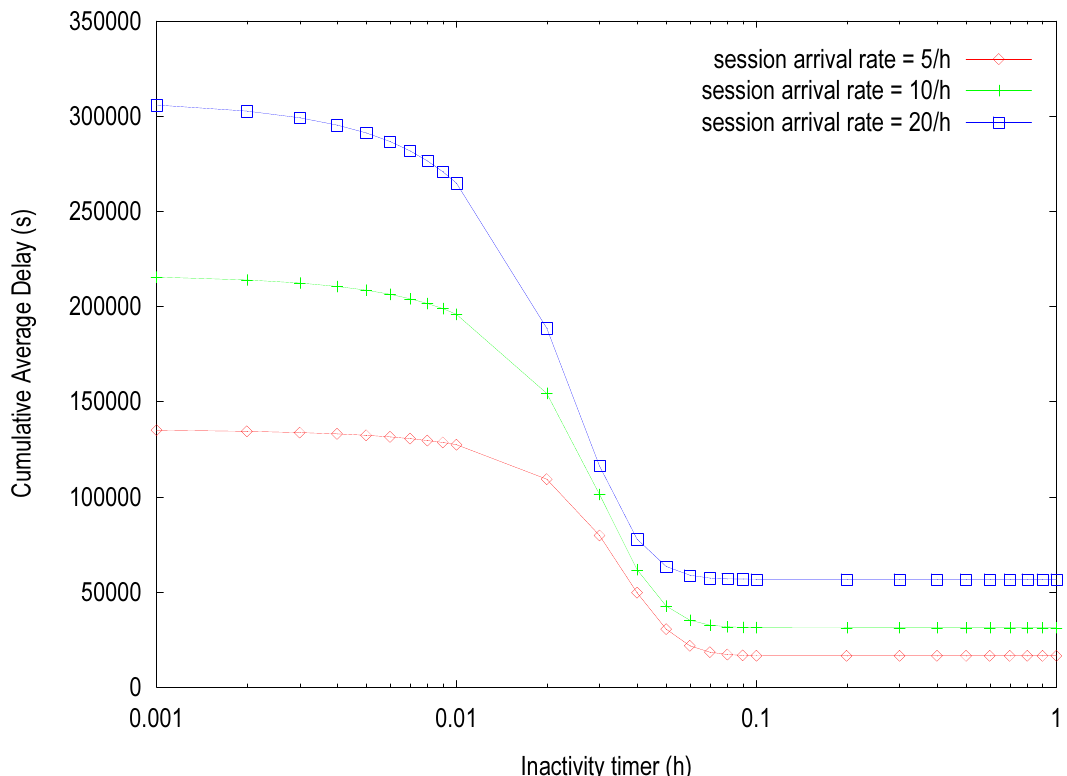
Figure 6. Cumulative average delay by varying the session arrival rate (small values of T and T ). E W